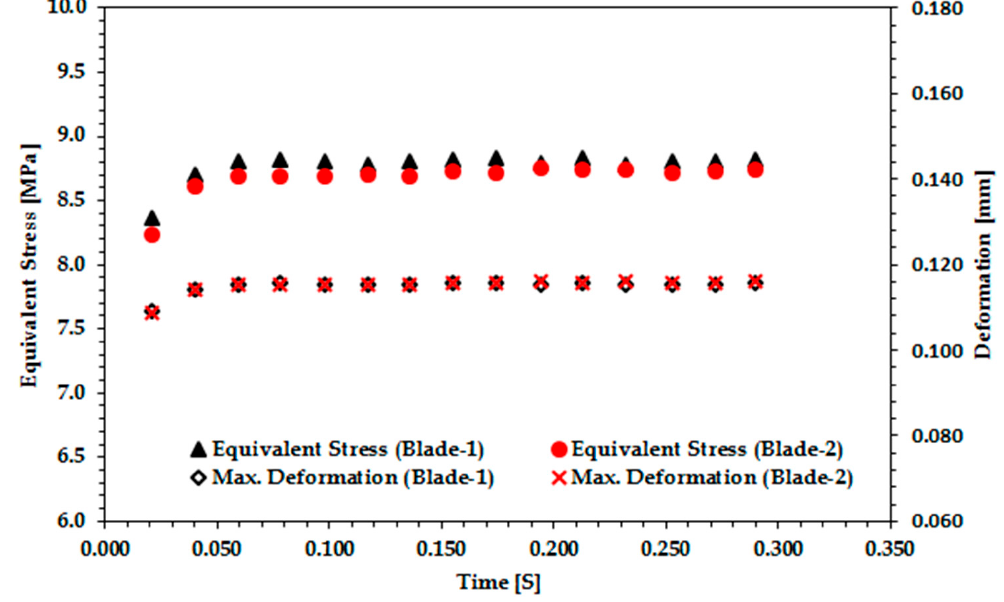
Figure 8. Variation of stress and deformation at rotating turbine blades for uniform flow.